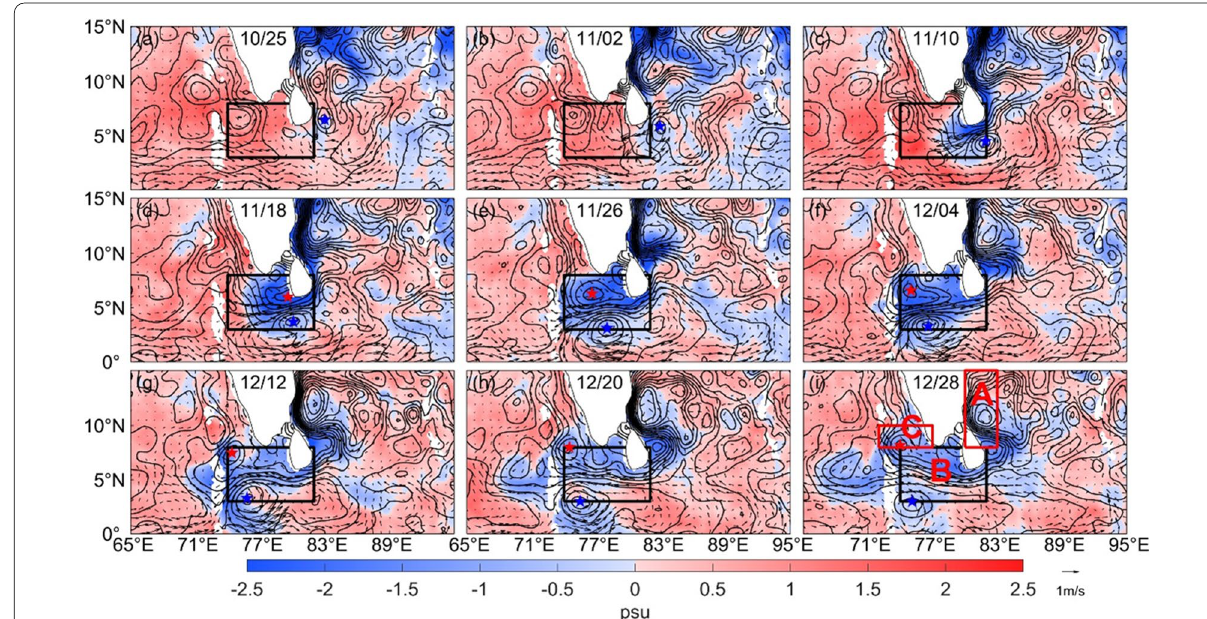
Fig. 4 Distribution of SSS anomaly (shading; psu), SLA (contour; m), and sea surface current (vector; m/s) in autumn and winter 2016. The red star represents the core of the anticyclonic eddy, and the blue star represents the core of the cyclonic eddy. A , B , and C represent the location of the area in Figs. 6 and 7,